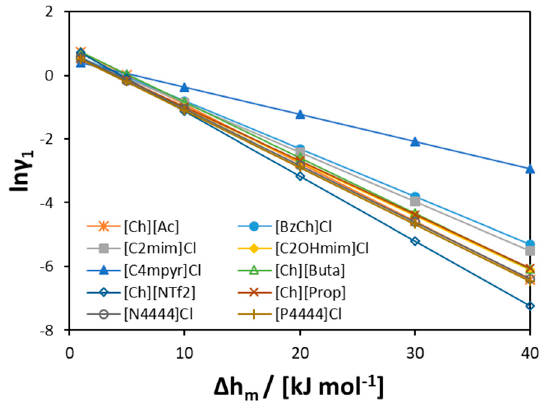
Figure 10. The activity coefficients of [Ch]Cl at the experimental eutectic point estimated assuming different melting enthalpies of [Ch]Cl.